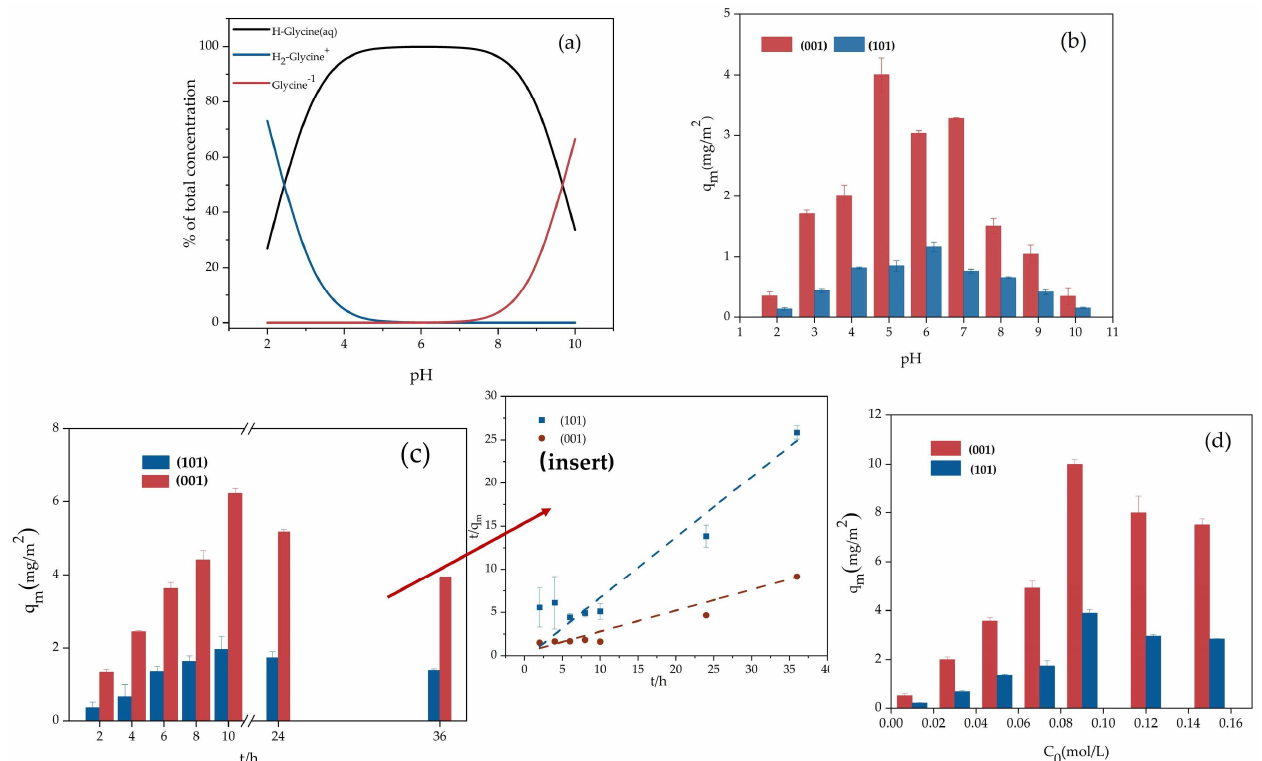
Figure 4. ( a ) The states of existence of glycine in different pH aqueous solutions. ( b ) Amount of glycine adsorbed on two kinds of anatase (TiO 2 ) at different initial pH levels. ( c ) Amount of glycine adsorbed on two kinds of anatase (TiO 2 ) for different adsorption times (insert: pseudo−secon−order kinetic fitting). ( d ) Amount of glycine adsorbed on two kinds of anatase (TiO 2 ) at different initial concentrations.